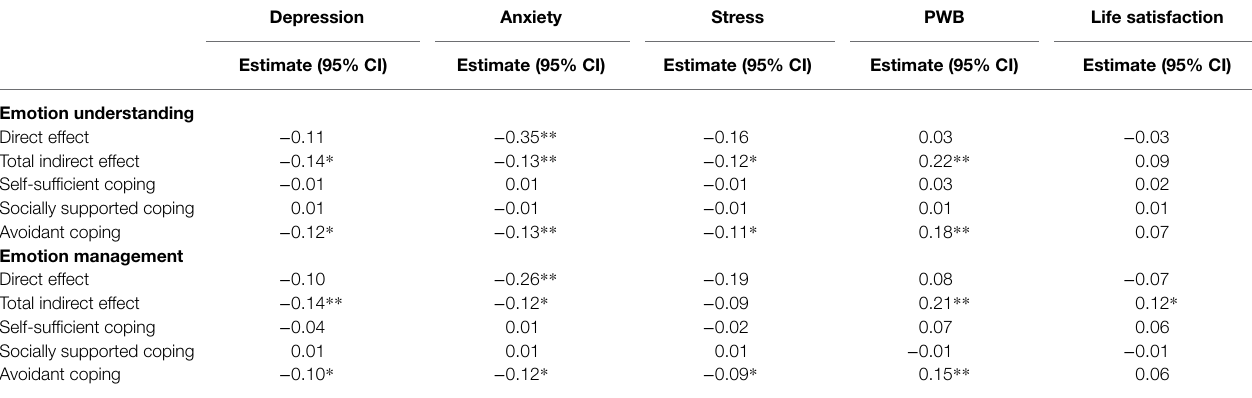
TABLE 2 | Indirect effects of EI on ill-being and well-being through coping (fully standardized estimates shown), Study 1, N =